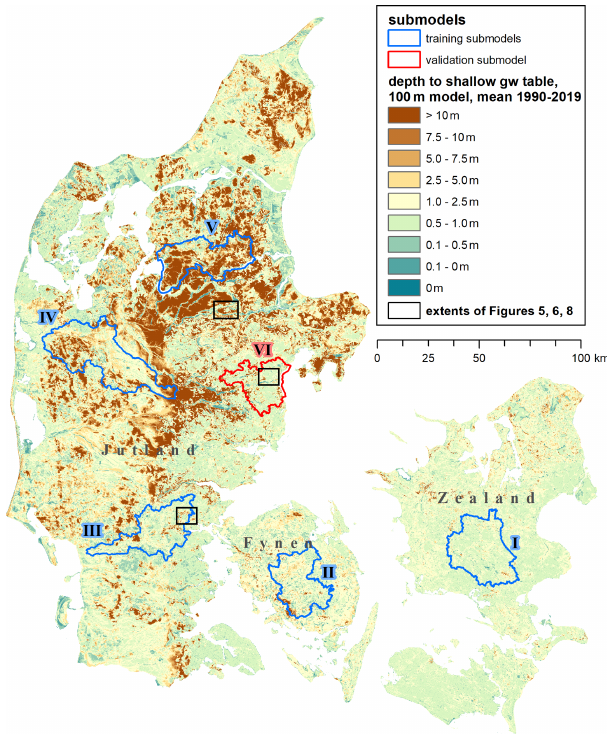
Figure 1. Denmark with the mean depth of the shallow groundwater table, as simulated by the DK-model HIP at a 100m resolution for the period 1990–2019. The submodels used for training and valida- tion of the downscaling algorithm are outlined in blue and red. The extents of the detail maps shown in Figs. 5, 6, and 8 are indicated as black